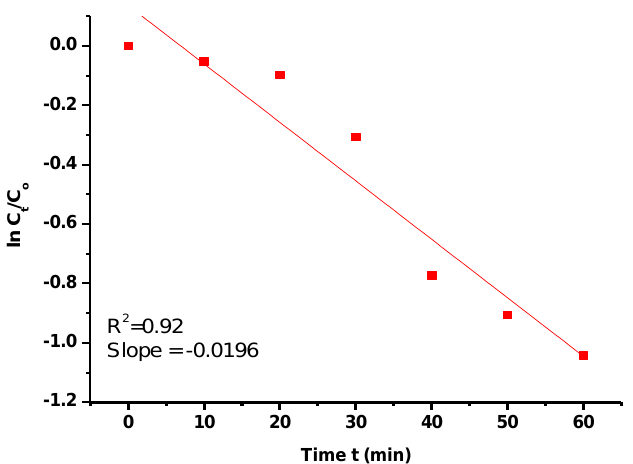
Figure 8. The kinetic plot for the adsorption-catalytic reduction of 4-nitrophenol.